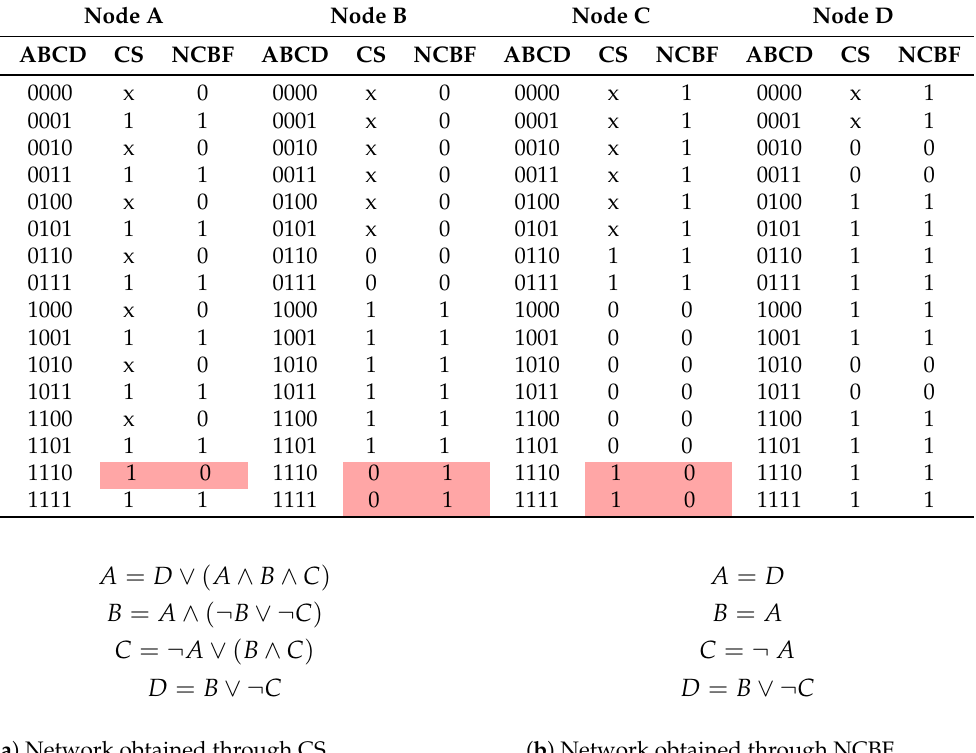
Figure 3. Directed graph to represent the system composed of four nodes (genes): A, B, C, and D with dependencies conveyed according to the standard set in Figure 1a. Table 1. Truth tables of the functions of the networks obtained through Conflicts Strategy (CS) and Nested Canalising Boolean Functions (NCBF). The letter x indicates an undefined value. The red cells show (by node) the discrepancies among the solutions of both methods. An undefined value can never be considered discrepancy given that it can be any value.